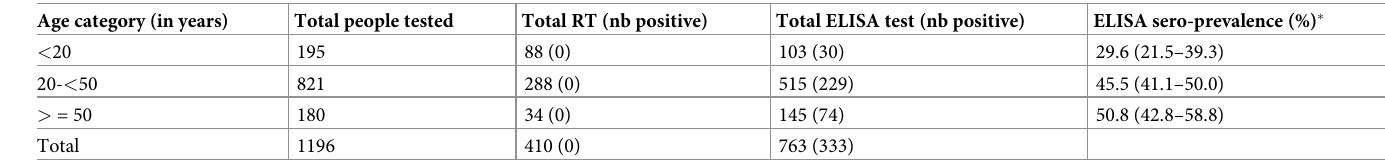
We assessed in livestock five potential risk factors for brucellosis sero-positivity. Overall, in livestock, no significant association was observed in the univariate analysis with the region and Table 3. Brucella tests results (rapid test and ELISA) in humans by age category. Age category (in years) Total people tested Total RT (nb